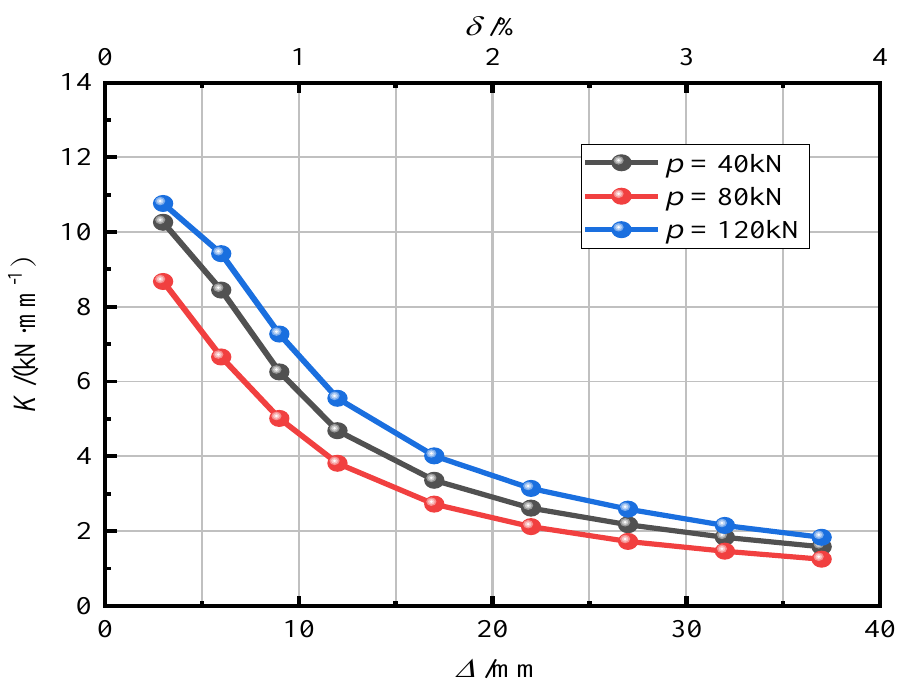
Figure 19. Stiffness degradation law.